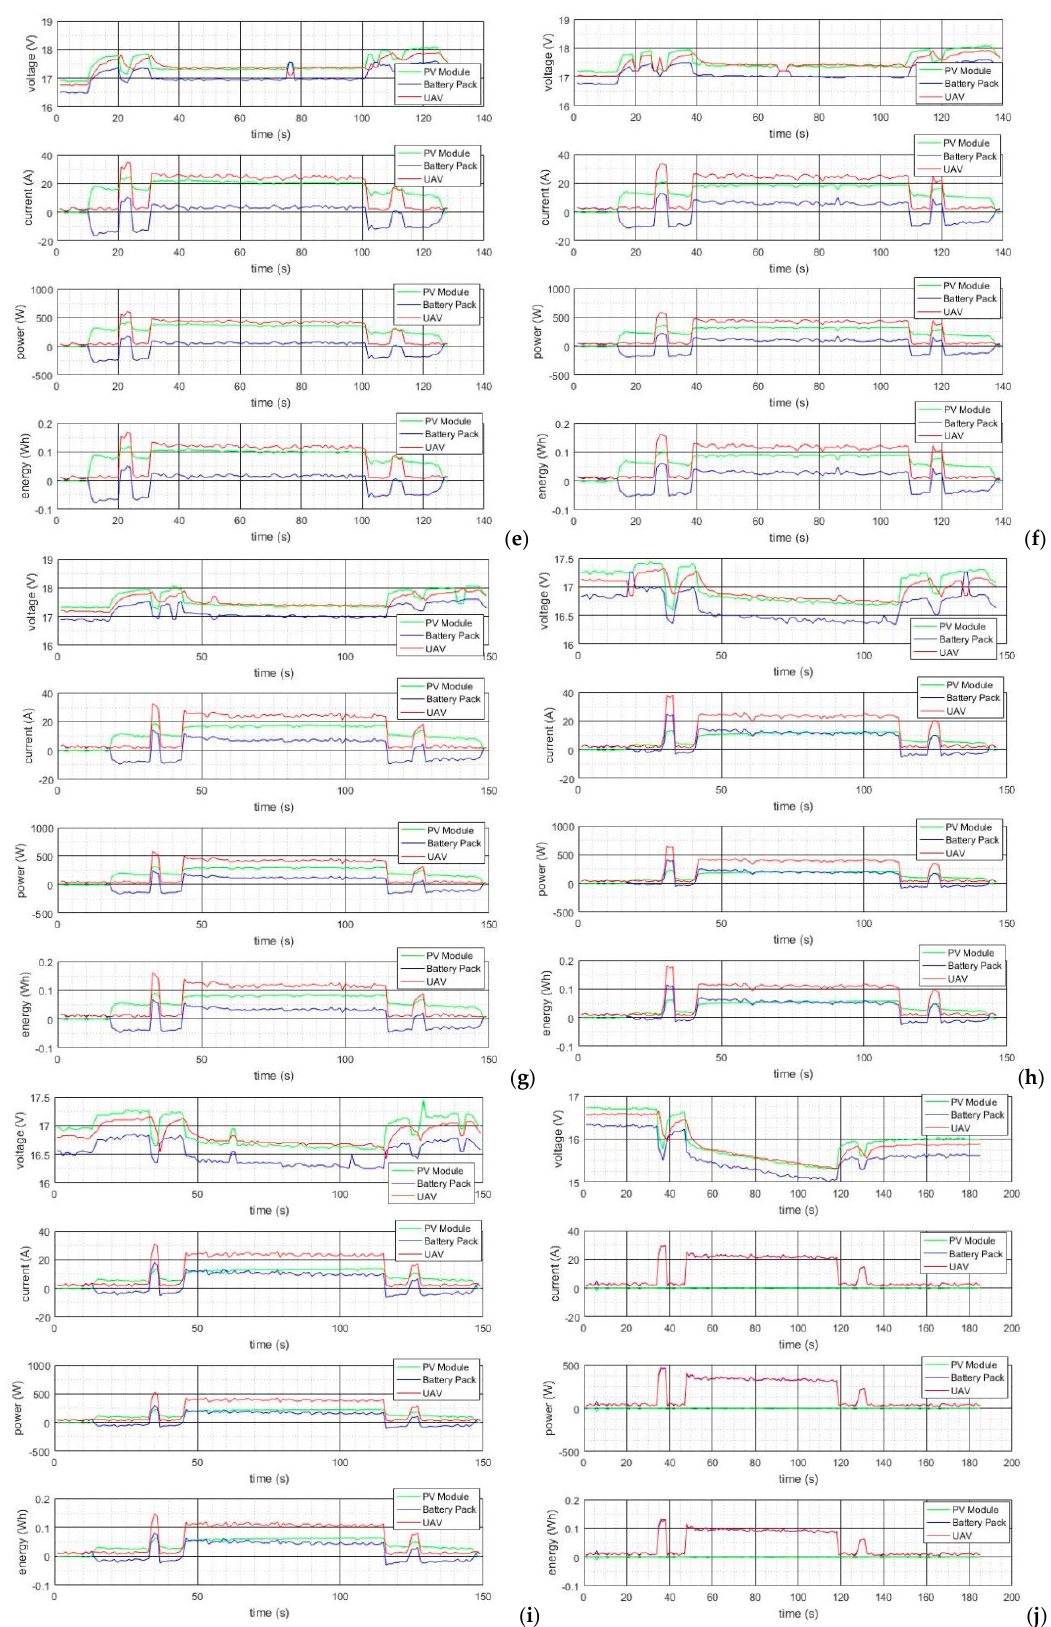
Figure 11. Current and voltage profiles for each time: ( a ) 09:00 a.m., ( b ) 10:00 a.m., ( c ) 11:00 a.m., ( d ) 12:00 p.m., ( e ) 13:00 p.m., ( f ) 14:00 p.m., ( g ) 15:00 p.m., ( h ) 16:00 p.m., ( i ) 17:00 p.m., and ( j ) 18:00